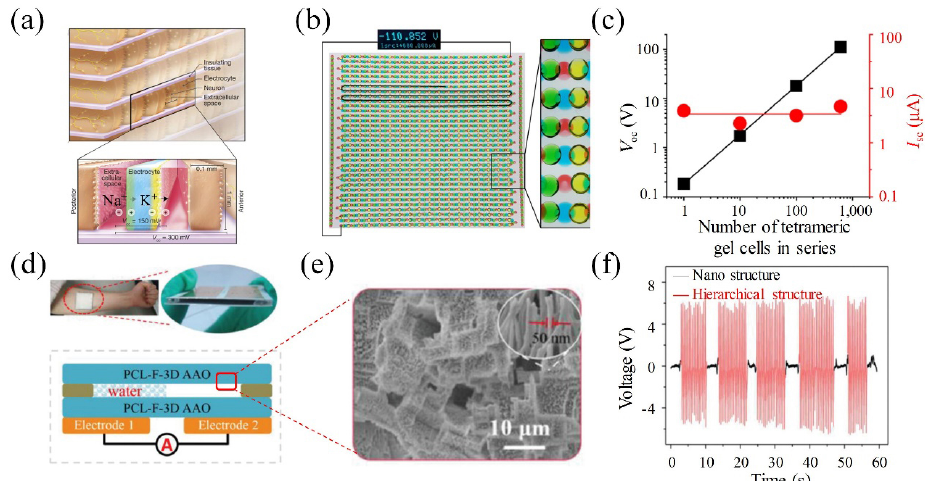
Figure 8 Bio-inspired water-driven wearable electricity generator. (a) Electrocytes’ arrangement within the electric organs of the electric eel. (b) Printed artificial electric organs fabricated by four compositions of hydrogel arrays. (c) Output characteristics of printed artificial electric organs. (a)–(c) Reproduced with permission from Ref. [137], © Macmillan Publishers Limited, part of Springer Nature 2017. (d) Photos and schematic diagram of a wearable water-driven electricity generator. (e) SEM image of micro-nano binary structure. (f) Voltage generated by arm swing in different motion states. (d)–(f) Reproduced with permission from Ref. [136], © Wiley-VCH Verlag